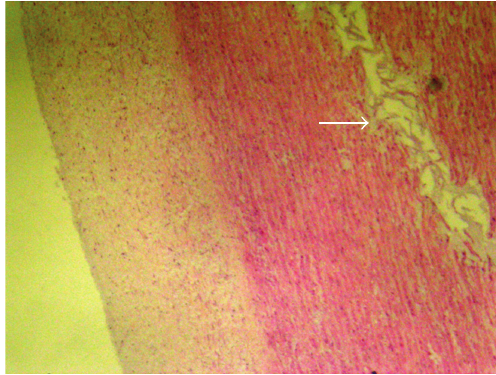
Figure 2: Pathological findings are demonstrating typical cystic medial degenerative changes. Histologically, it had the appearance in the media of “cystic spaces” filled with mucoid materials (arrow). (Hematoxylin & Eosin, original magnification ×